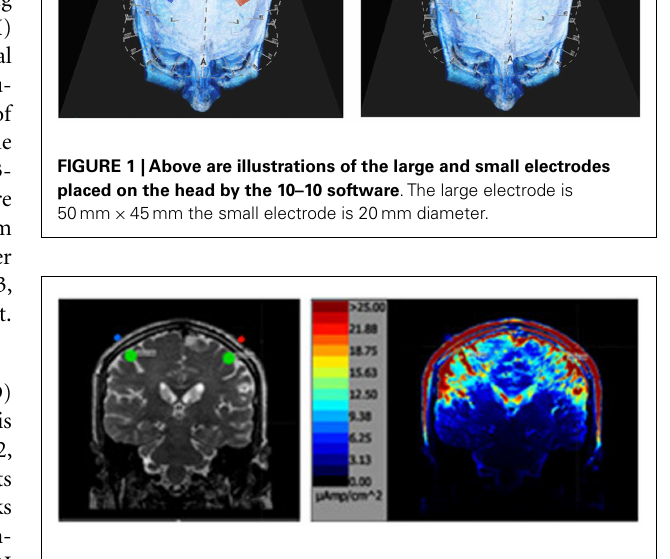
FIGURE 2 |The above left image is aT2 MRI slice with the areas of interested outlined in green directly under each parietal electrode .The image on the right is the same slice after the